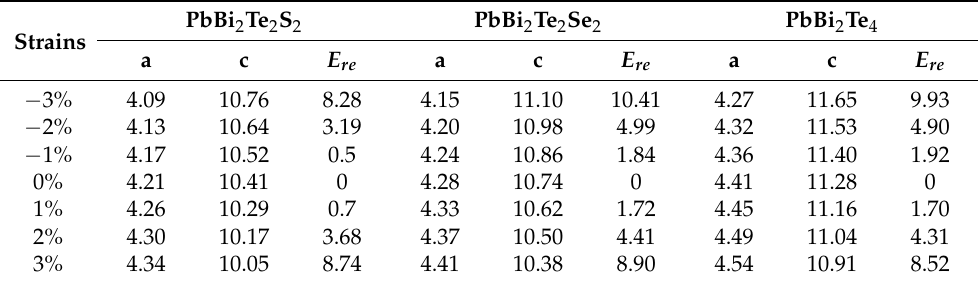
Table 3. Calculated lattice parameters a (nm), thickness c (nm), and relative energy E re = E strained −